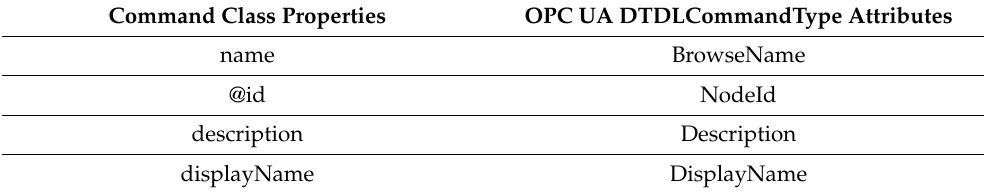
Table 10. Mapping of properties of the Command class into the OPC UA DTDLCommandType